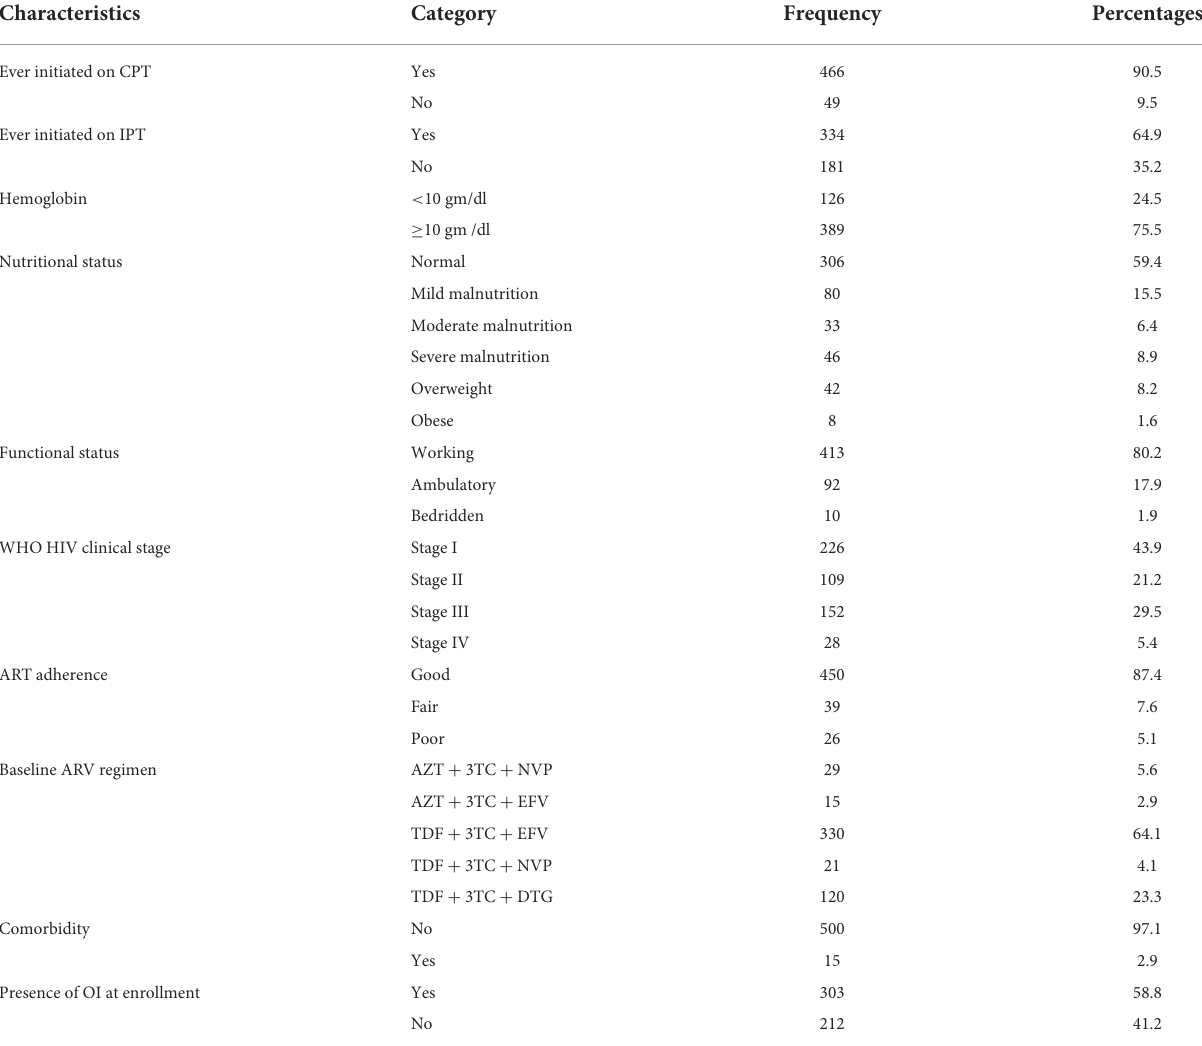
TABLE 2 Clinical, laboratory, and treatment-related characteristics of participants on ART at WSUCSH, Southern Ethiopia, 2012–2021 ( n = 515).